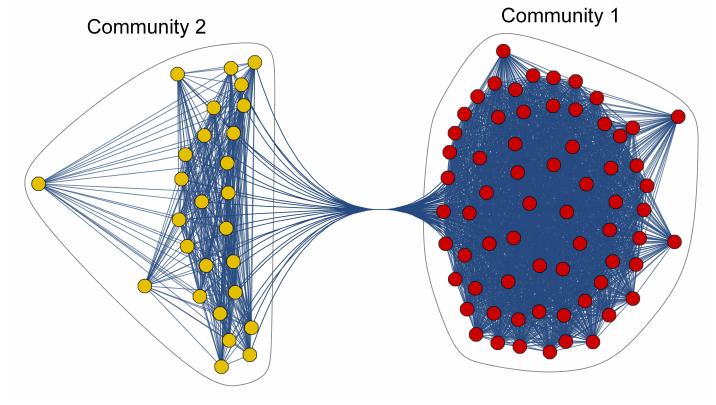
Fig. 3 The community plot of the resulting